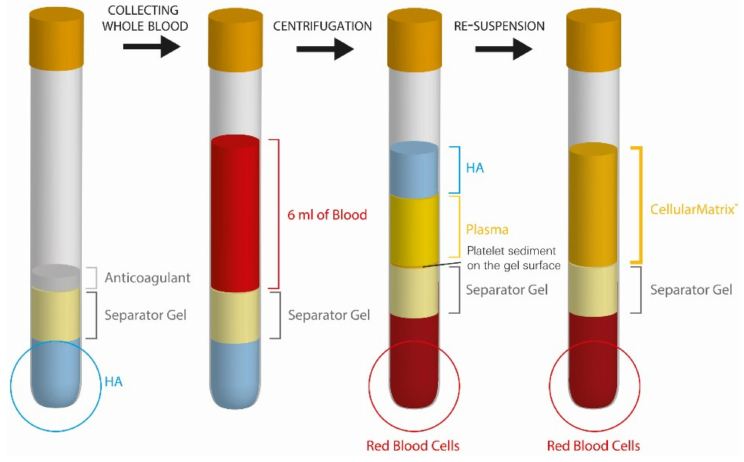
Figure 3. Different steps of preparation of the PRP-HA mix with Cellular Matrix tubes.